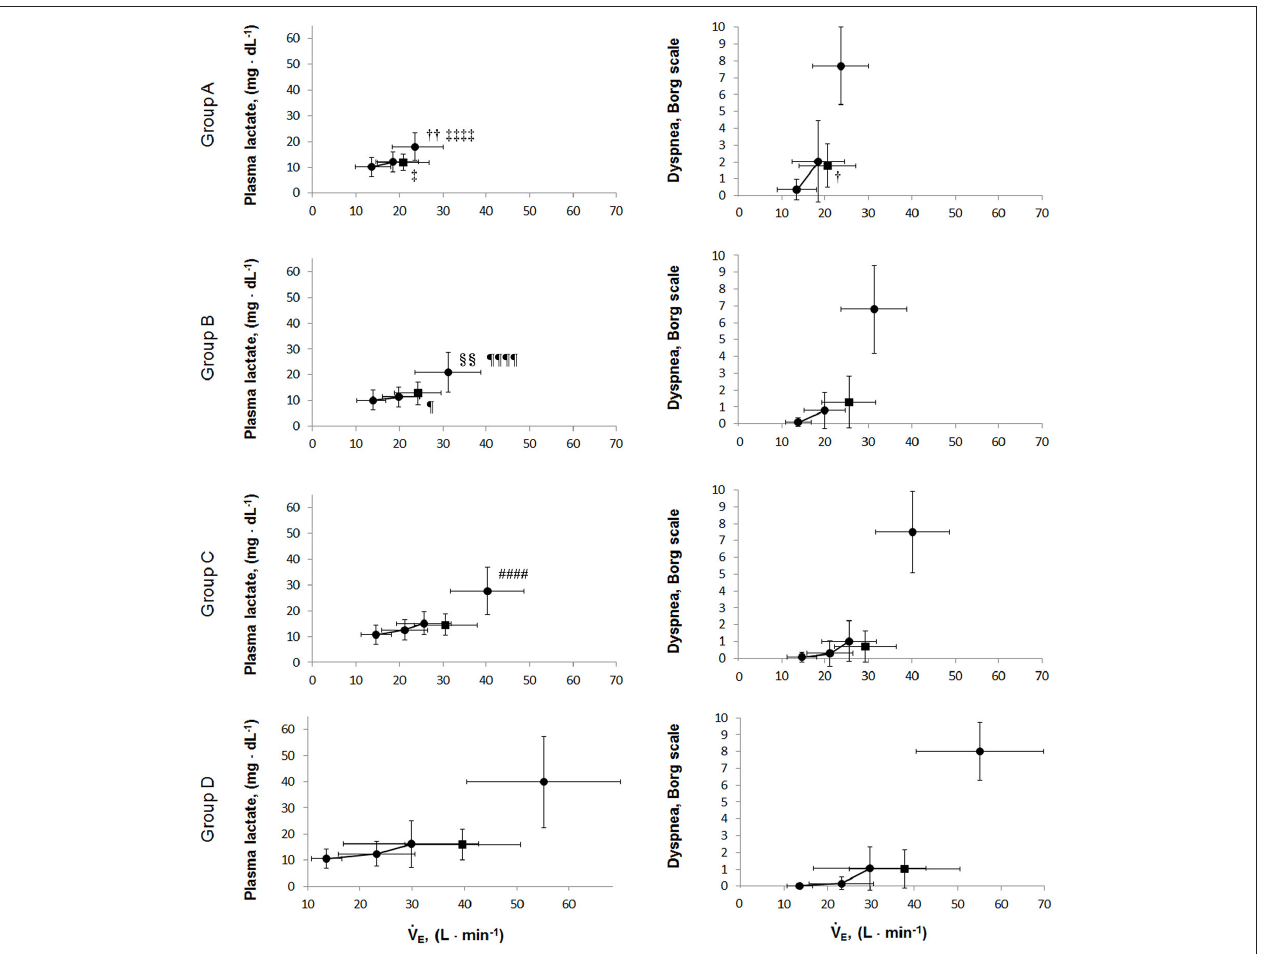
FIGURE 6 | The relationships of the plasma lactate levels and dyspnea borg scales during exercise. Values are presented as mean (SD) and were analyzed using the Tukey-Kramer honestly significant difference test. Circular symbols show exertional variables at rest, during exercise, and at peak exercise. Square symbols show plasma lactate and dyspnea borg scale break points. Plasma lactate borg scale break points were determined in 15/28 in group A, 43/64 in group B, 55/77 in group C, and 42/46 group D. Dyspnea borg scale break points were determined in 14/28 in group A, 46/64 in group B, 62/77 in group C, and 40/46 group D. A vs. B; † p < 0.05, †† p < 0.01, A vs. D: ‡ p < 0.05, ‡‡‡‡ p < 0.0001; B vs. C: §§ p < 0.01, B vs. D: ¶ p < 0.05, ¶¶¶¶ p < 0.0001; C vs. D: #### p <